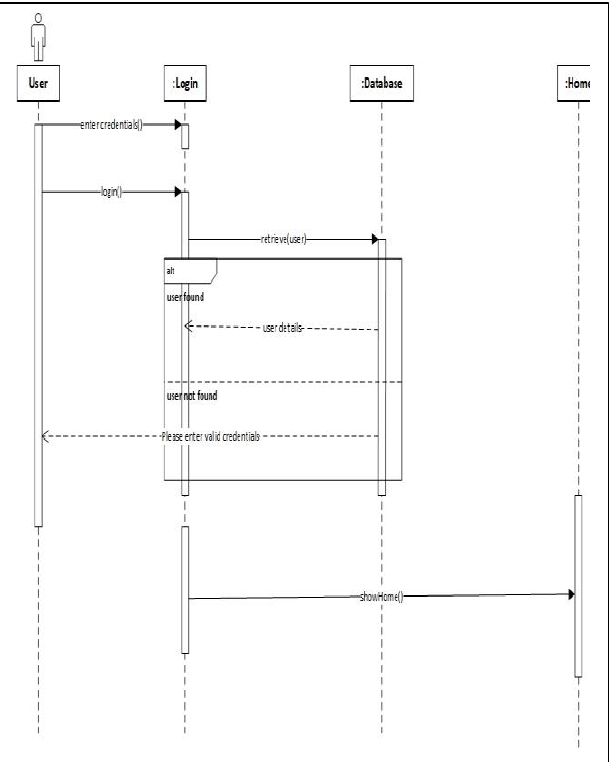
Figure 10. Receptionist Sequence